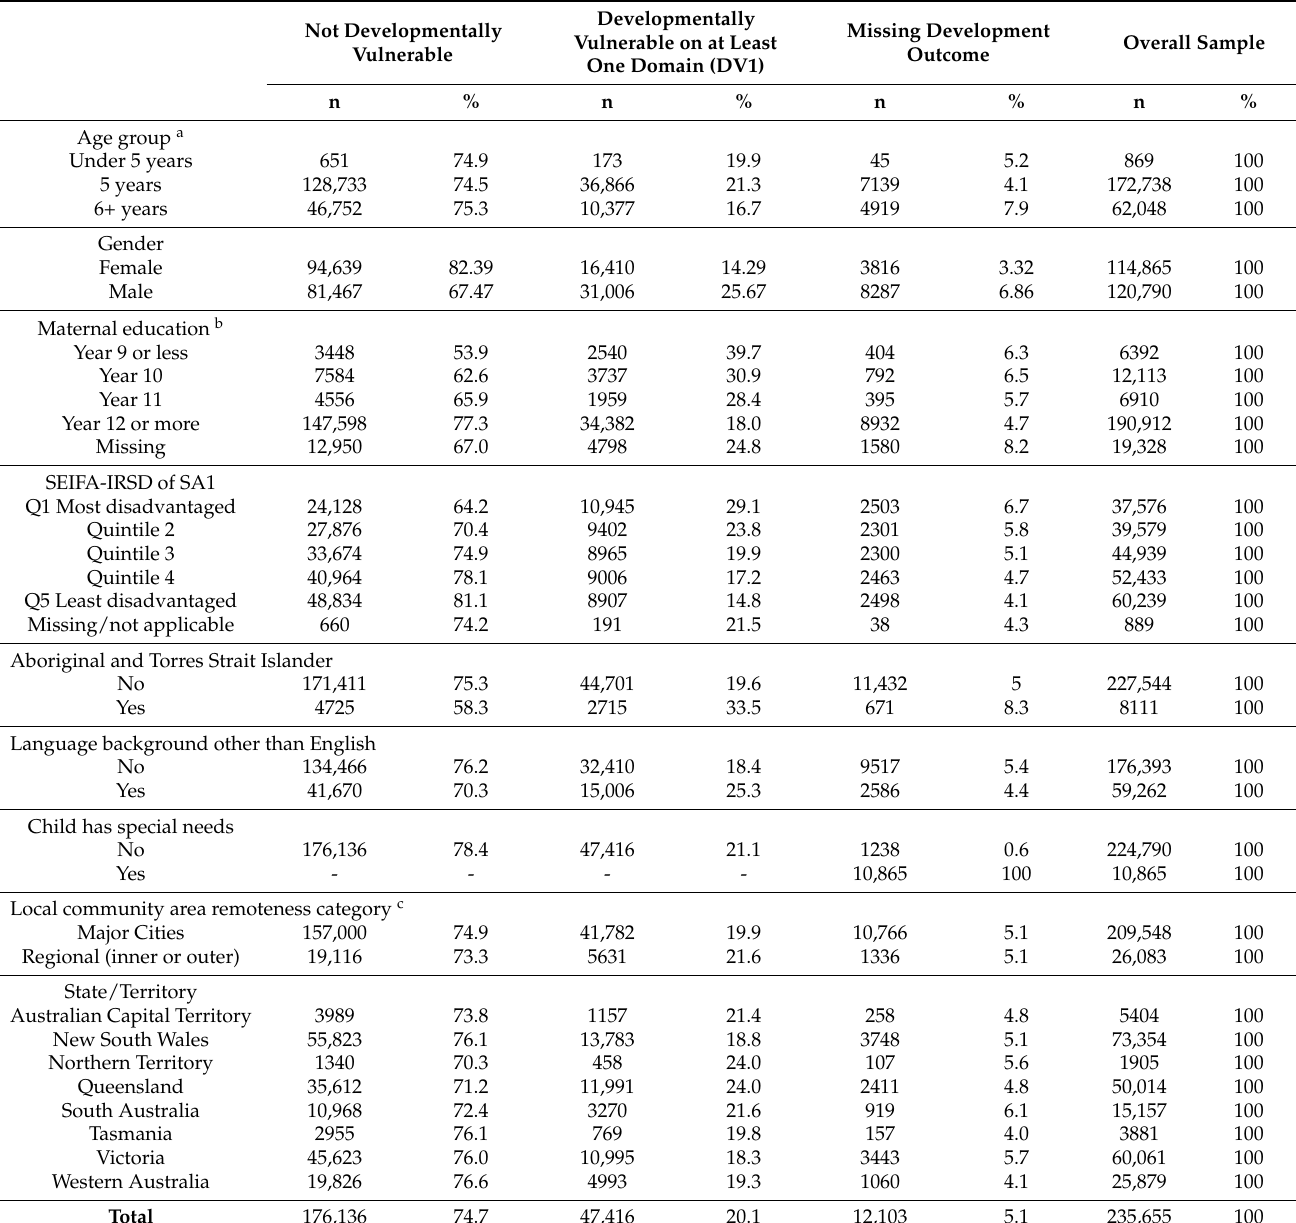
Table 2. Sample demographics of the AEDC-BE by child development